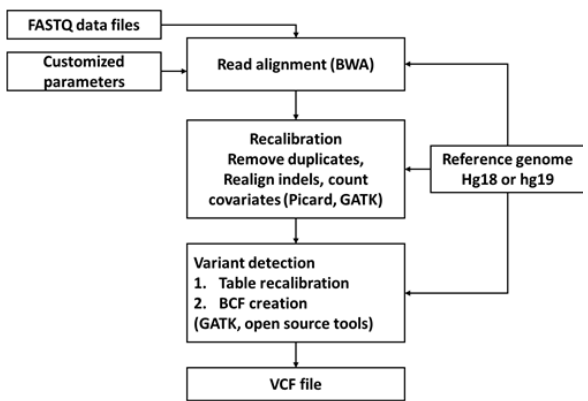
Figure 1. View of DNA sequencing